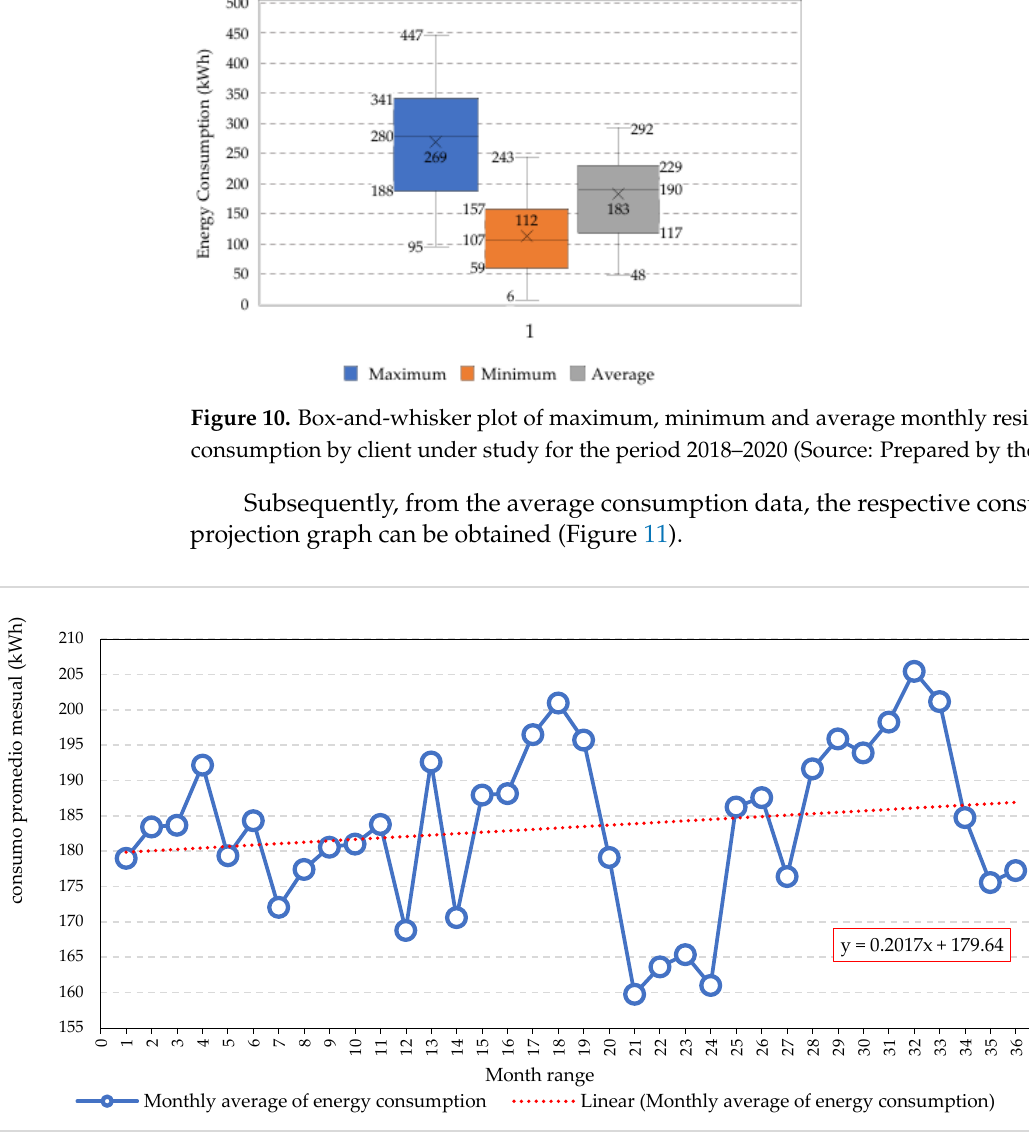
Figure 11. Monthly averages of energy consumption of all clients for the period 2018–2020. Note. January 2018 (range 1); December 2020 (range 36) (Source: Prepared by the